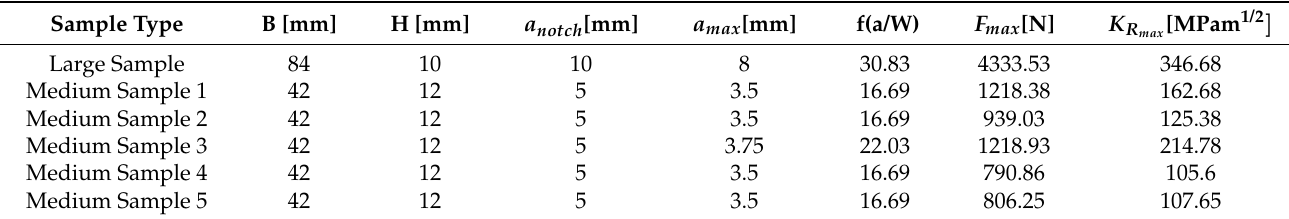
Table 2. Data for ASTM E399